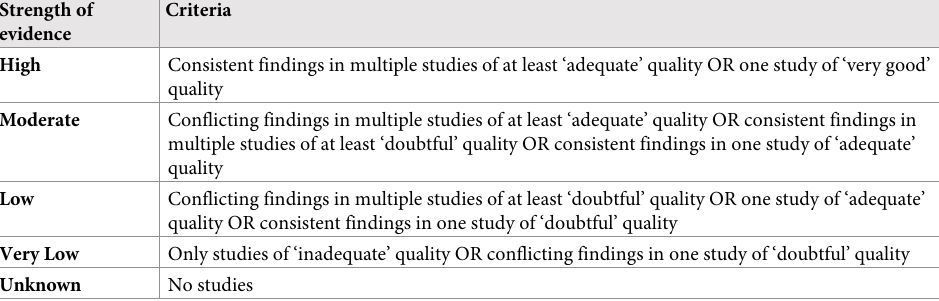
Table 3. Criteria used for summarizing the strength of evidence (Part